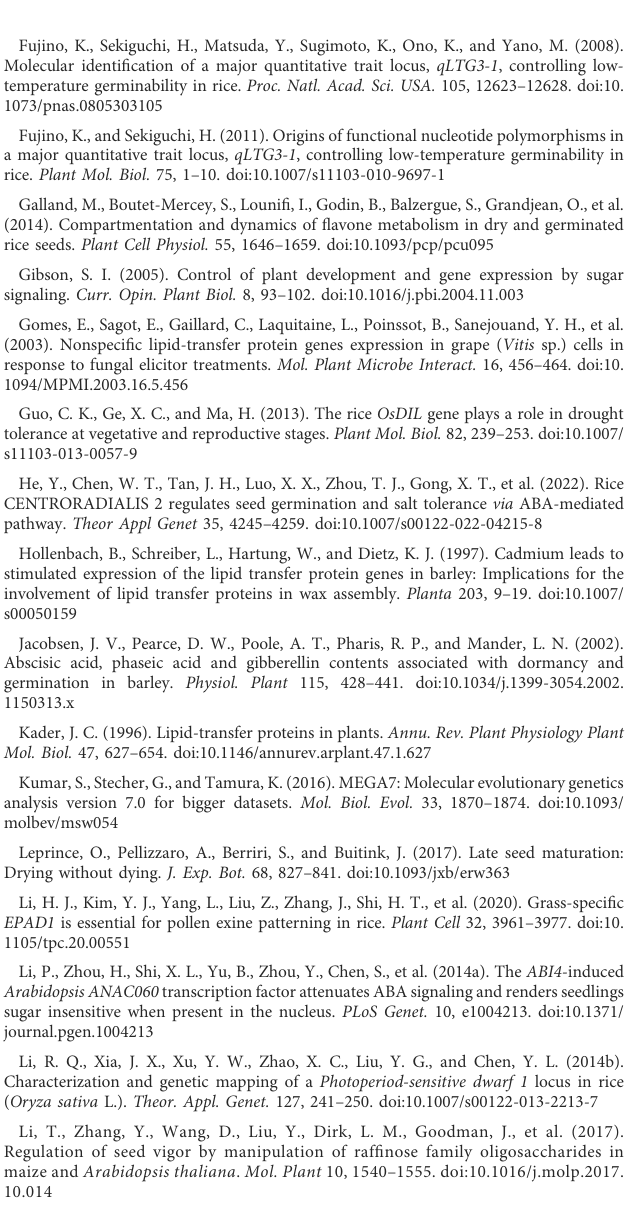
SUPPLEMENTARY FIGURE S1 Nucleotide sequences at the target site in eight heterozygous mutants. The recovered mutated alleles are shown below the NIP sequence. The target site nucleotides are indicated with black capital letters. The PAM site is underlined. The red dashes indicate deleted nucleotides. The red capital letters indicate inserted nucleotides. SUPPLEMENTARY FIGURE S2 OsLTPL23 expression detection in osltpl23 mutants. Each column presents the means±standard deviations of three biological replicates. Values are the mean±standard deviations of three biological replicates. Signi fi cance were generated by Student ’ s t-test with * p < .05 and ** p <